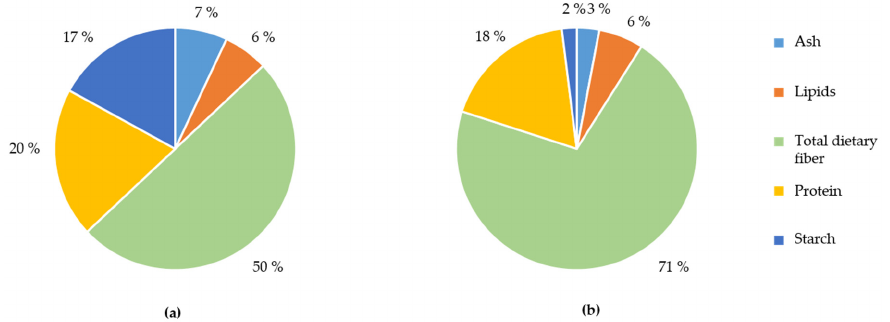
Figure 2. Unmodified wheat bran (WB) and wheat bran with reduced particle size (WB RPS) ( a ) contain less total dietary fiber and more starch compared to destarched pericarp ‐ enriched wheat bran (PE WB) ( b ).